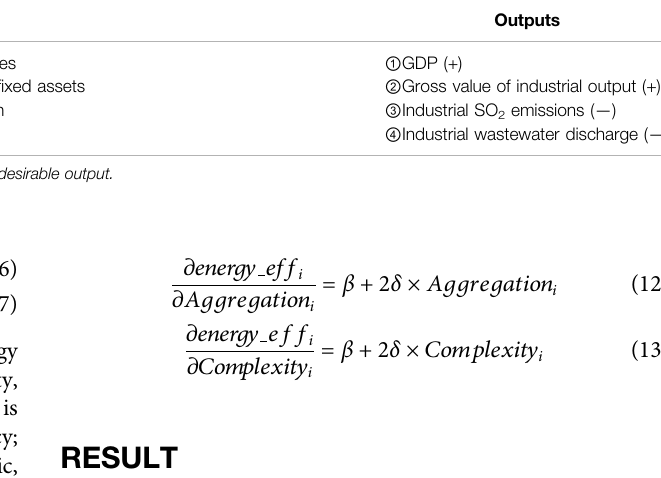
Table 2 represents the baseline estimates for the net effect of urban spatial form on energy ef fi ciency. Among them, regression Equations 1 – 3 only investigate the linear effects of urban spatial centrality, aggregation, and complexity on energy ef fi ciency; In